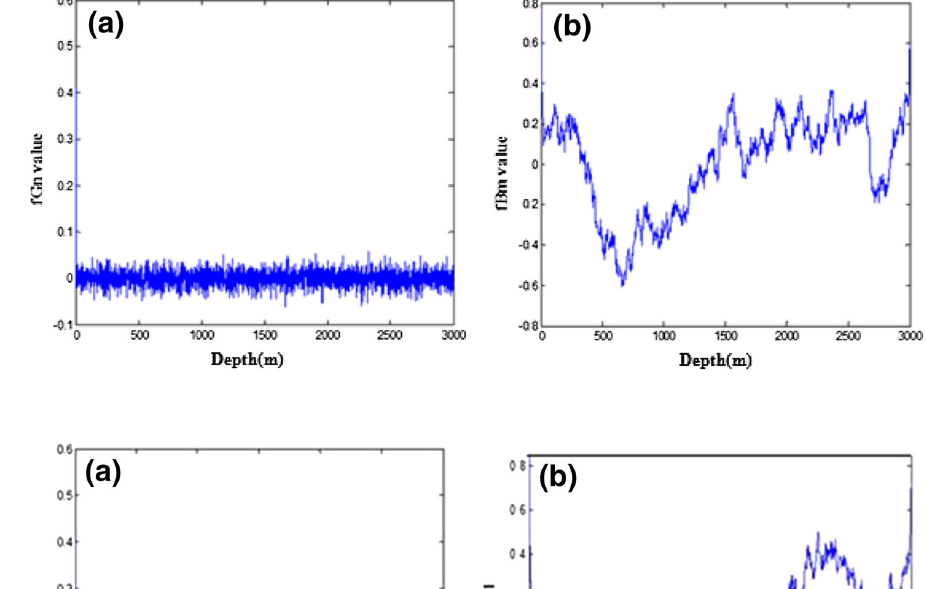
Fig. 6 Two realizations with fractal structure for well log porosity in well B; ( H = 0.4671). a fGn model,